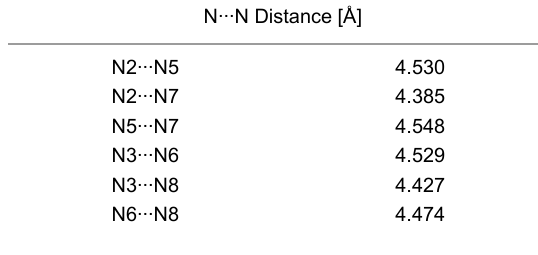
Table 4: Selected non-bonded distance (Å) of complex 1